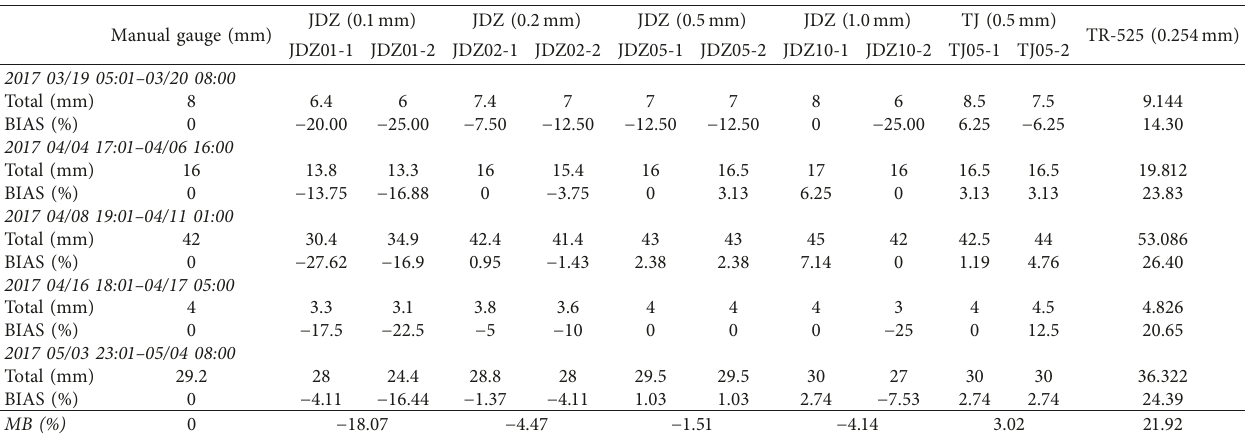
Figure 4: (a) Rainfall data measured by RG3-M gauges at the hydrometeorological observation field during 18 rainfall events compared to data recorded at the adjacent MG (bars represent event totals, and lines represent cumulative rainfall depth). (b) The relationship between BIAS and rainfall intensity (rainfall total ÷ even duration) using event total amounts. (c) The distribution of RRMSEs at four rain intensity ranges. Table 2: Total precipitation (mm) and BIAS (%) for 11 rain gauges against the manual gauge in five rainfall events at hydrometeorological observation